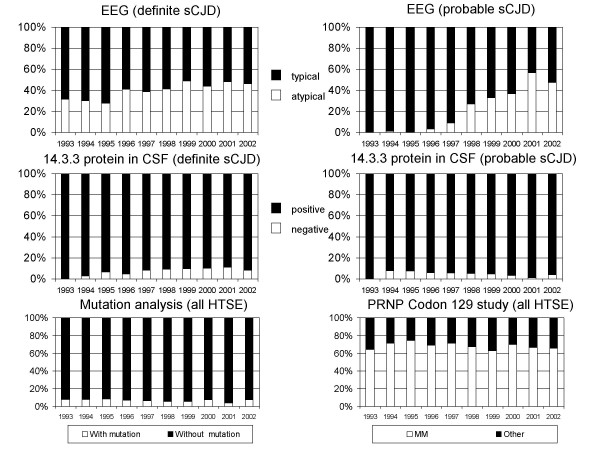
Annual distribution of positive results in EEG and 14.3.3 protein tests in sCJD, and for all HTSE, PRNP mutations identified (in patients who had and had not been genetically studied) and PRNP codon 129 genotype.